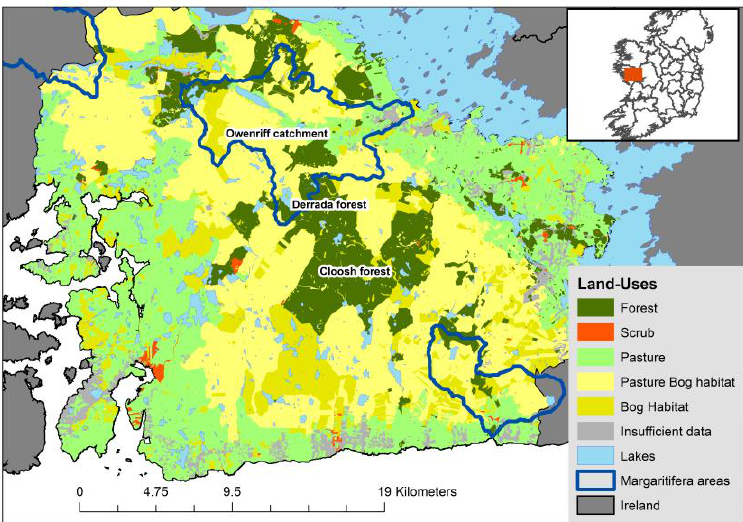
Figure 1. The Barony of Moycullen Case Study Area (CSA) in County Galway, Ireland, delineated by its land-uses. Pasture Bog Habitat is bog utilised for commonage pastures. Margaritifera areas refer to catchments with freshwater pearl mussels. The Cloosh Forest is the forest area at the centre of the CSA, Derrada is located north of Cloosh. The Owenriff catchment contains much of the Derrada forest and it is located just north of Cloosh. Table 1. Descriptive statistics for the case study area relating to climate (1981–2010), land-use, and forest data. Climate data from [37] , land-use, forest, and soil data from the GIS sources listed in Table 2. Barony of Moycullen Temperature July mean range (°C) 12–19